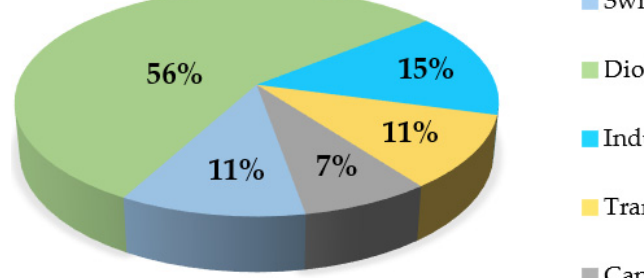
Figure 18. Voltage-gain comparison with other similar converters in [3,10,14,25].